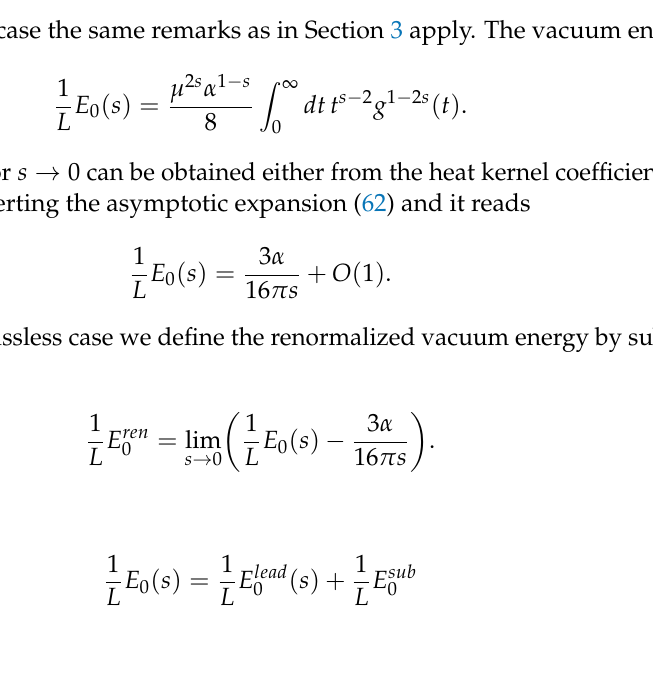
Figure 5. The vacuum energy E ren of a massive scalar field with repulsive self-interaction on the 0 whole axis. All quantities are given in units of the mass m e